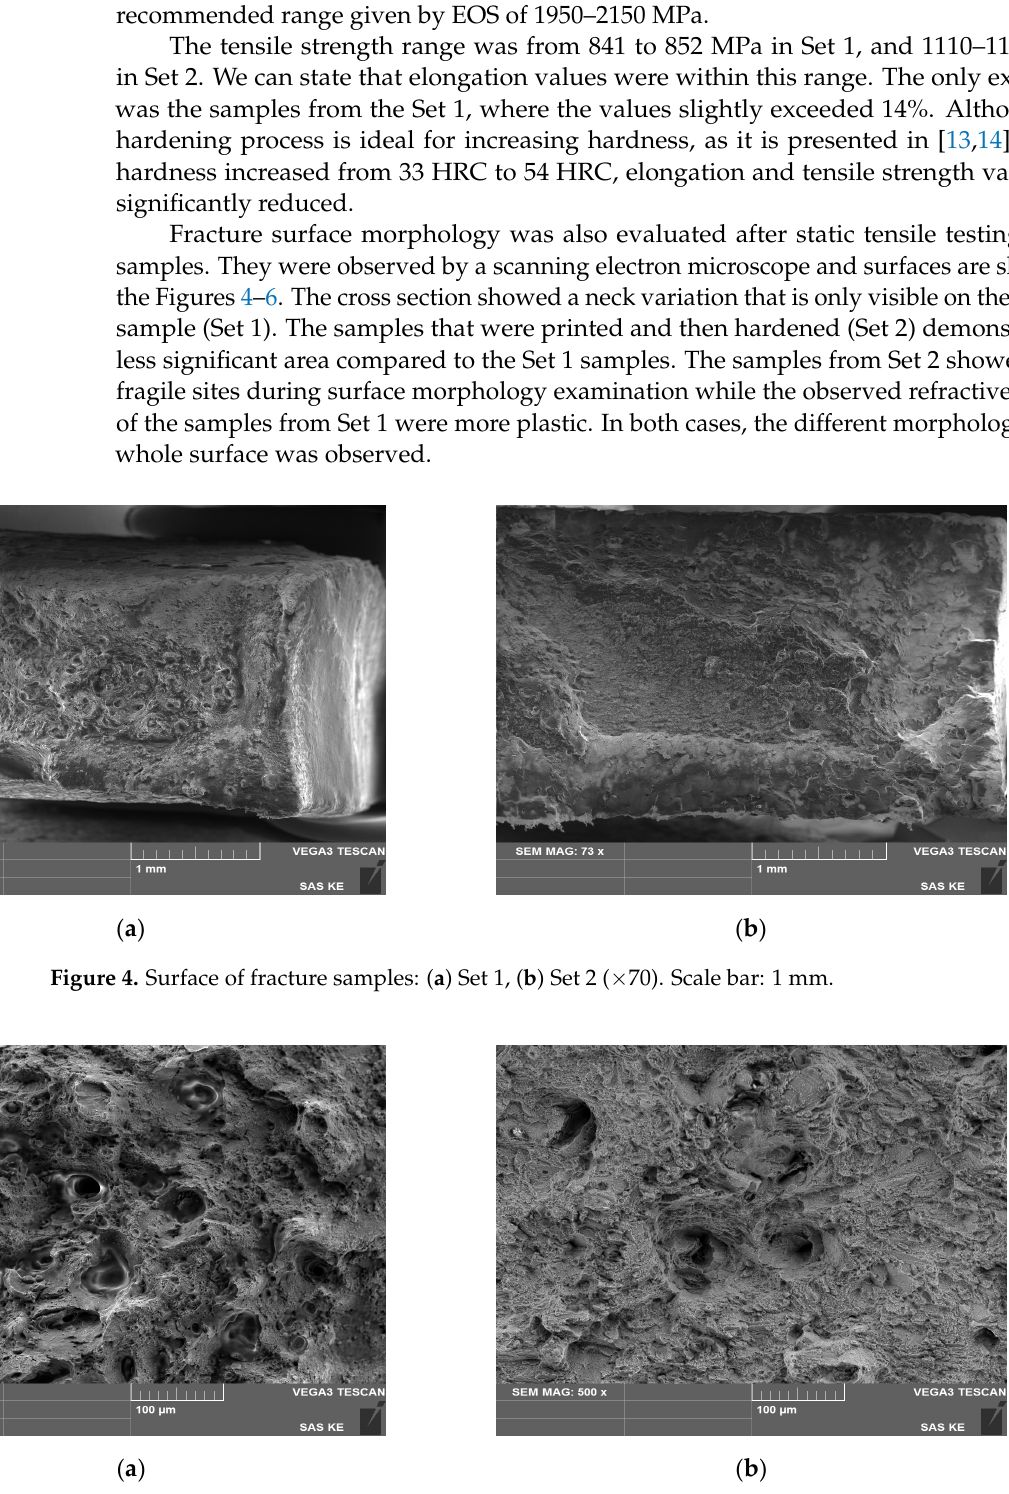
Figure 5. Surface of fracture samples: ( a ) Set 1, ( b ) Set 2 (×500). Scale bar: 100 µm.